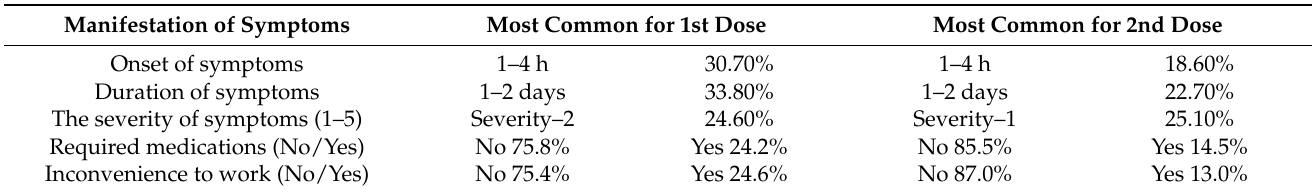
Table 3. The most common presentation of how symptoms manifested after Sinopharm vaccination dose one vs. dose two.